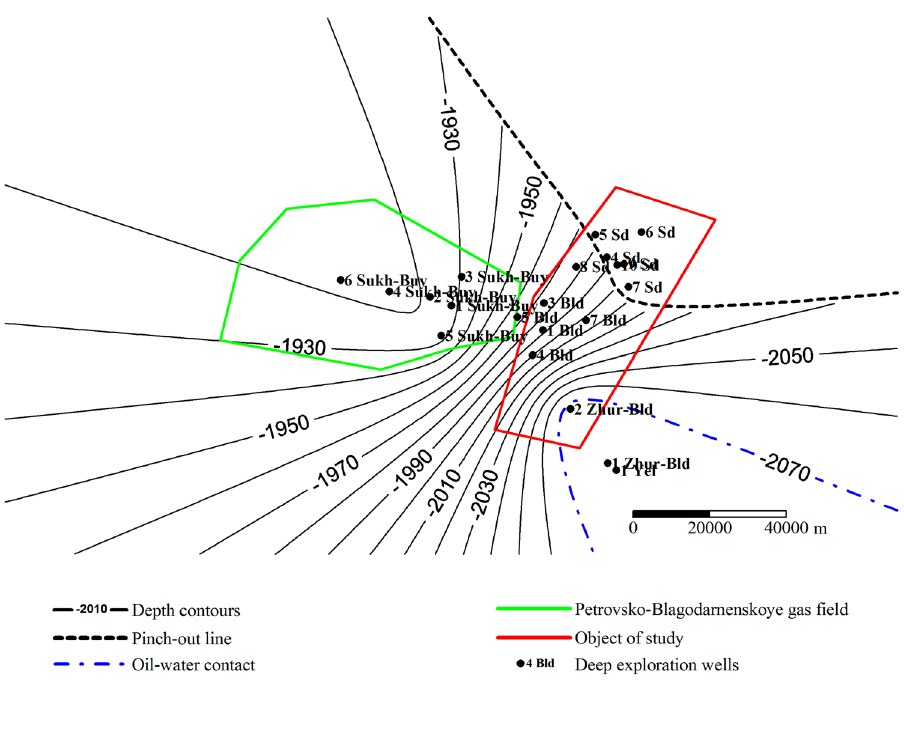
Fig. 9 Top of the Paleocene Layer